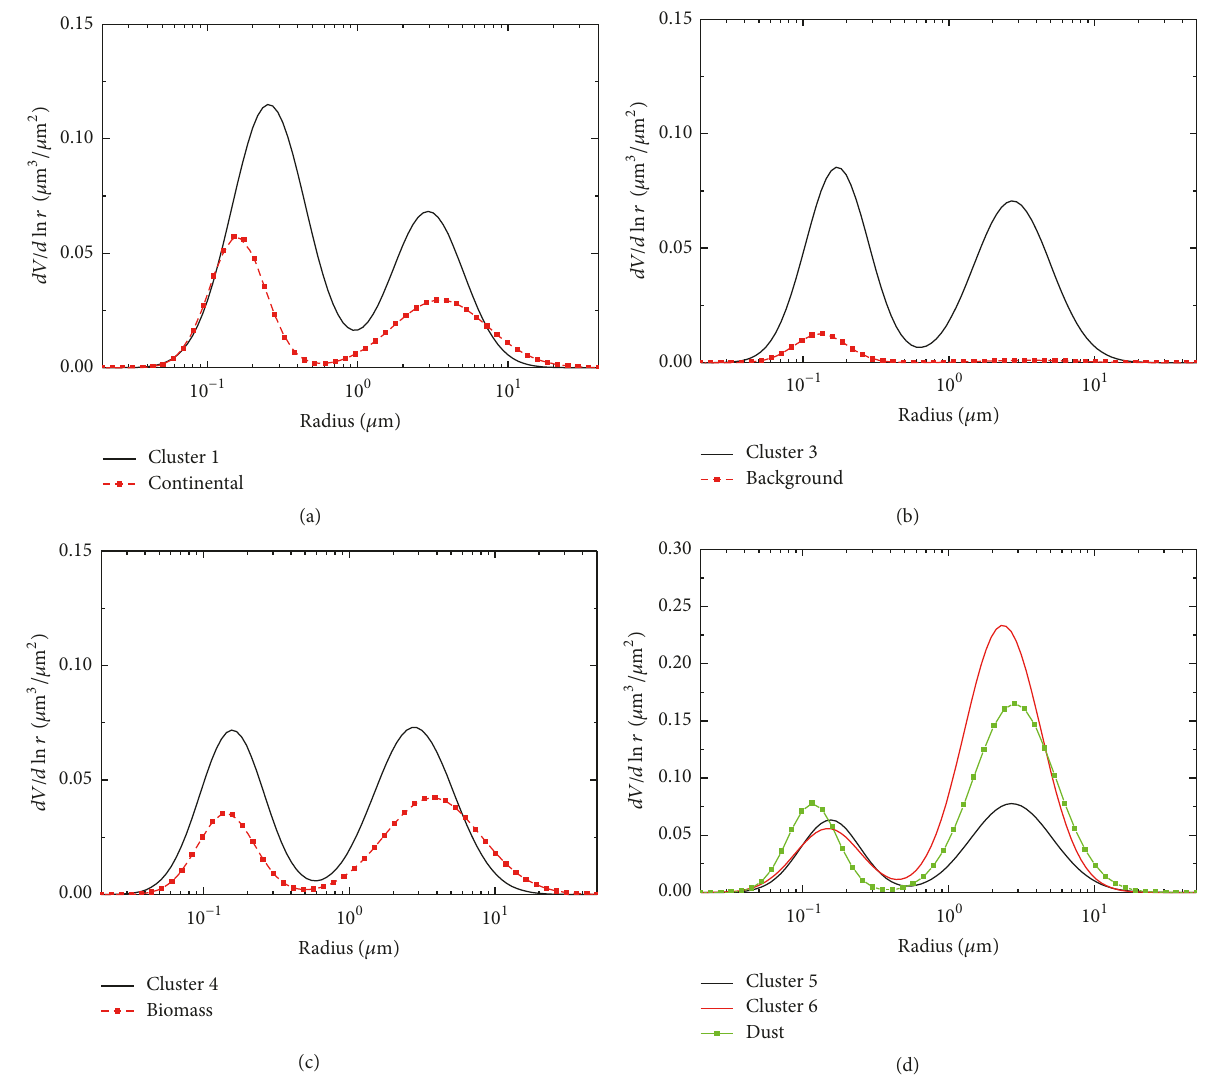
Figure 6: Size distribution comparison with global aerosol